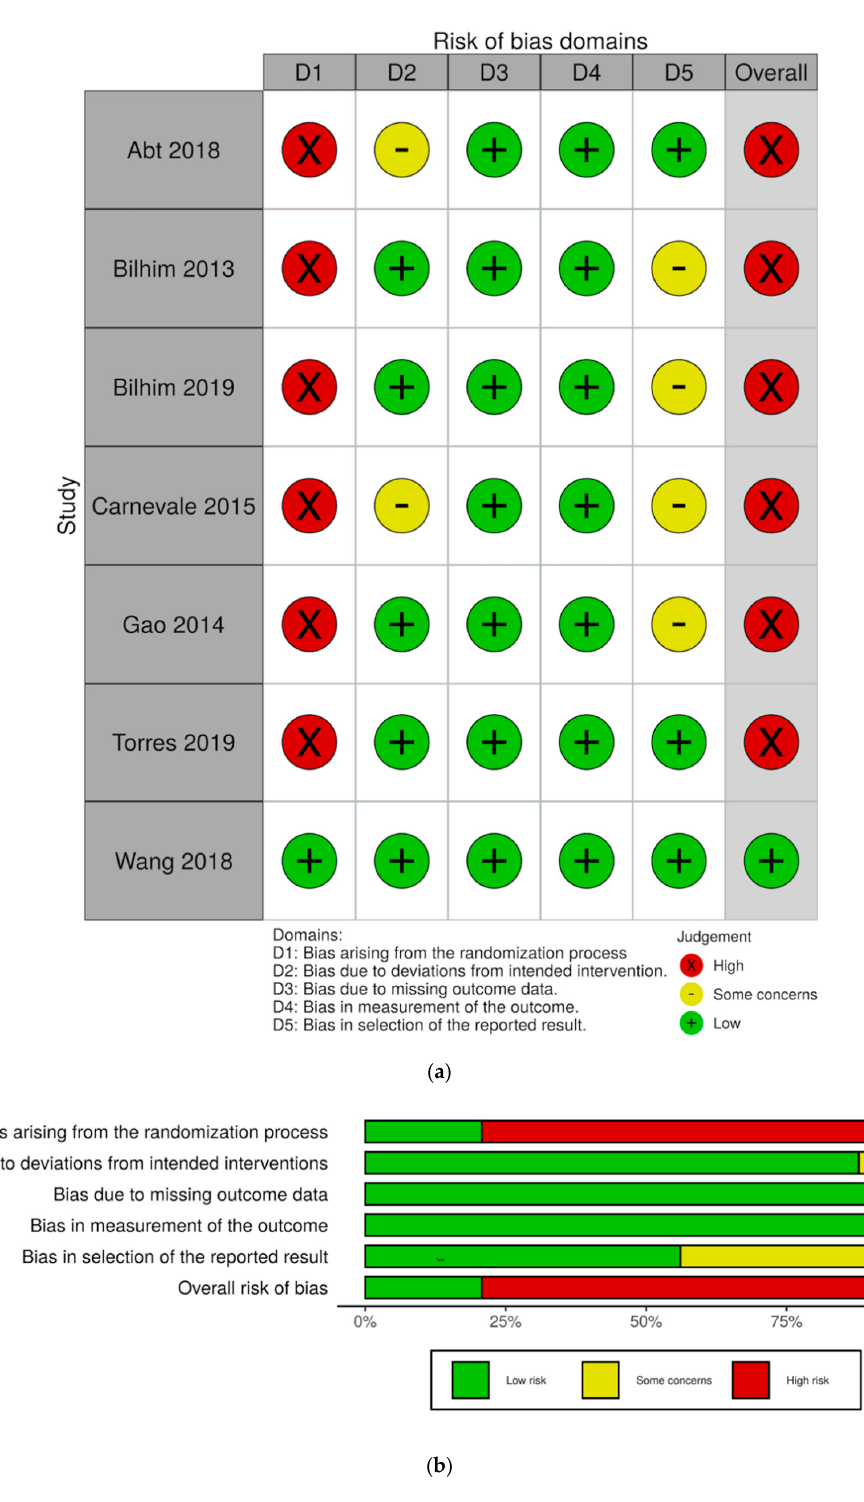
Figure 3. RoB2 assessments of RCTs. ( a ) “Traffic-light” illustration of risk of bias in individual studies. ( b ) Weighted bar plots depicting risk of bias judgement distributions within each domain.